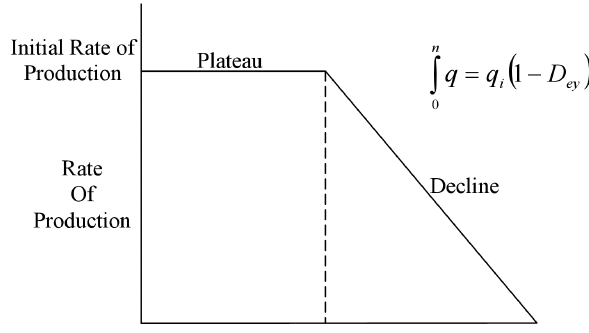
Figure 4—A rate model by using decline curve analysis.